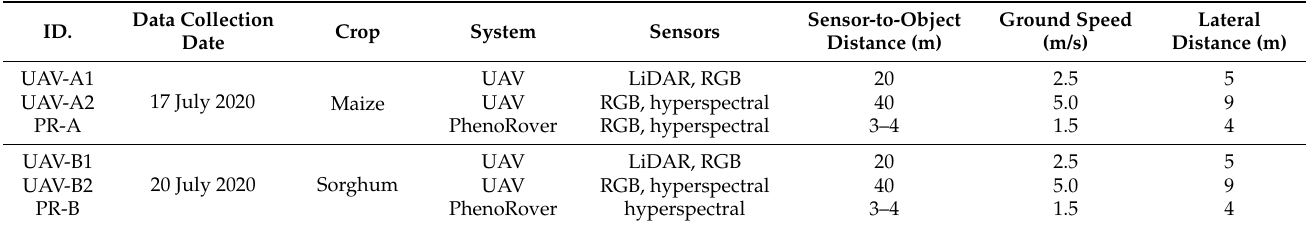
Table 1. Flight/drive-run configuration for datasets used in this